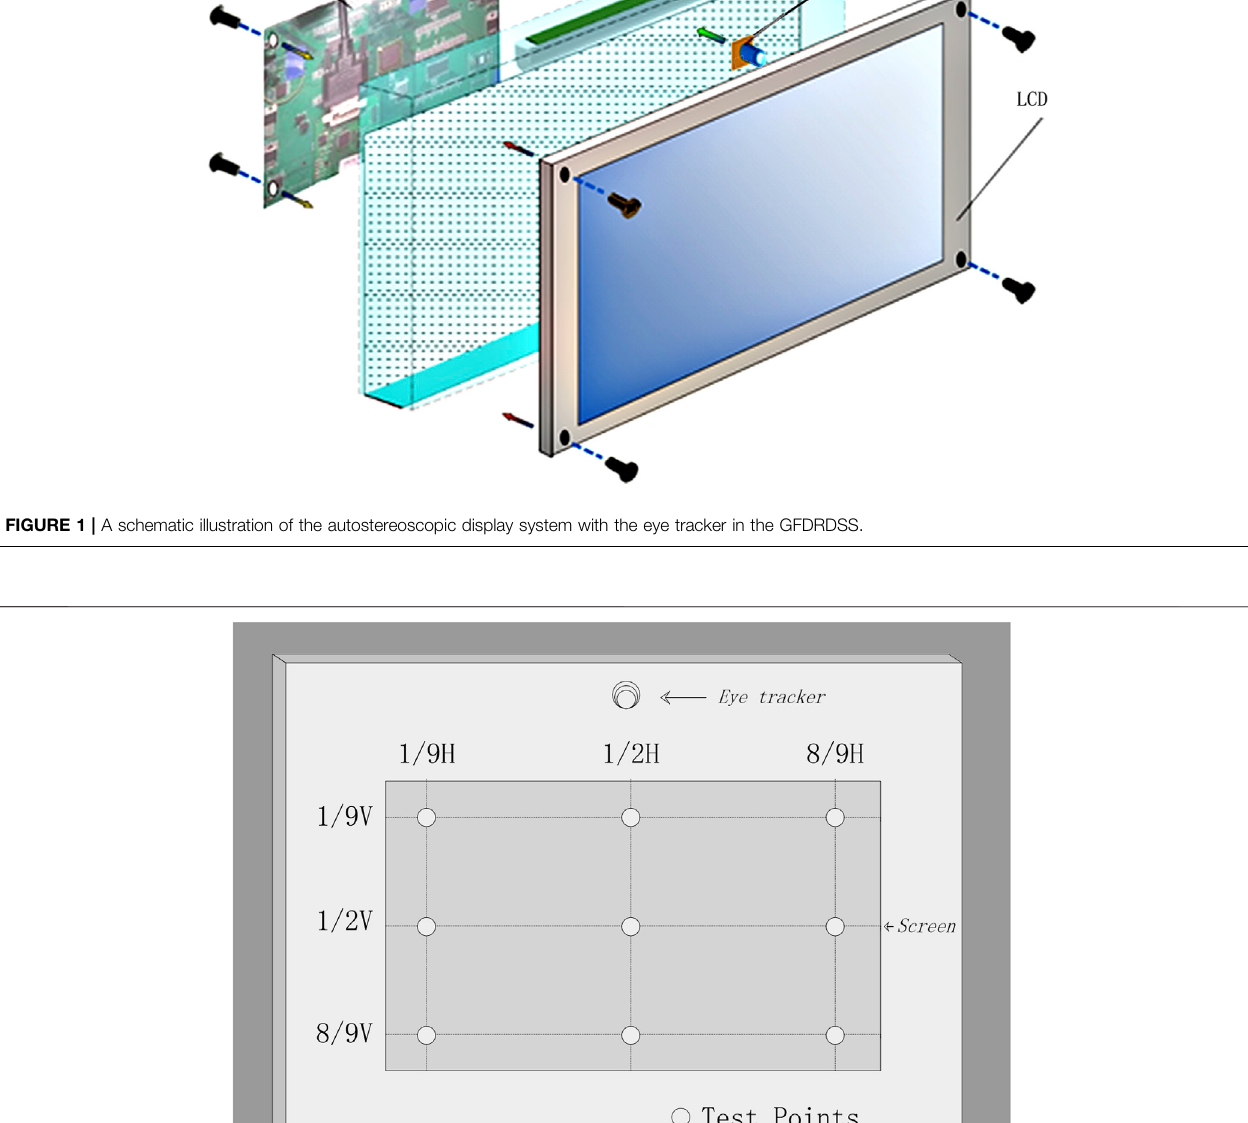
Frontiers in Bioengineering and Biotechnology |